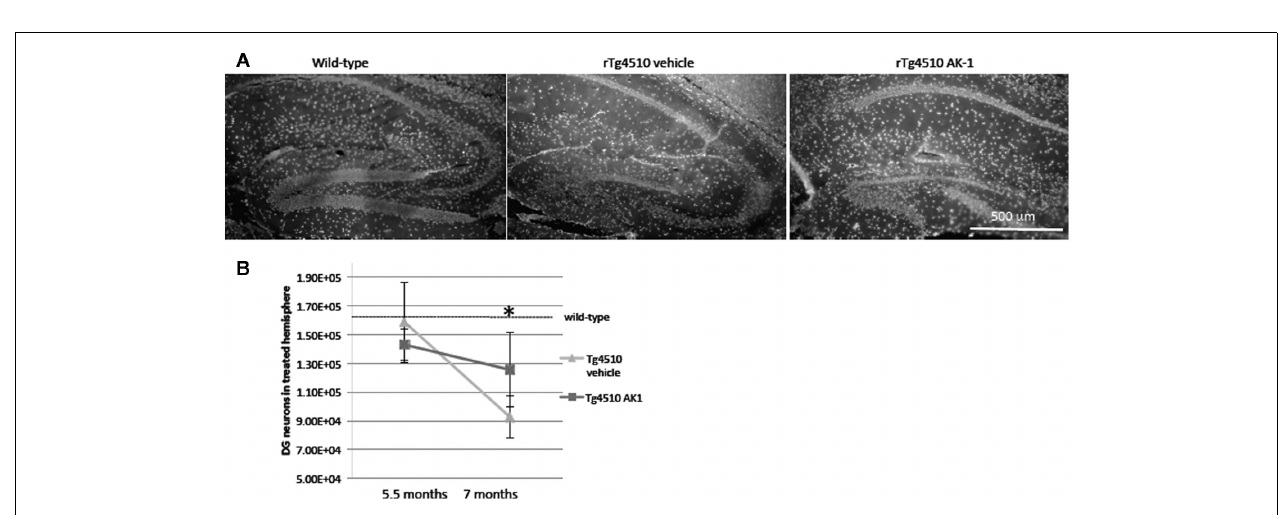
FIGURE 3 |AK1 treatment does not affect numbers of PHF1-positive neurofibrillary tangles. Micrographs from rTg4510 mice treated from 4 to 5.5months with vehicle (A) or AK1 (B) show that both treatment groups have PHF1 positive neurofibrillary tangles (red) in the treated CA1. Quantification